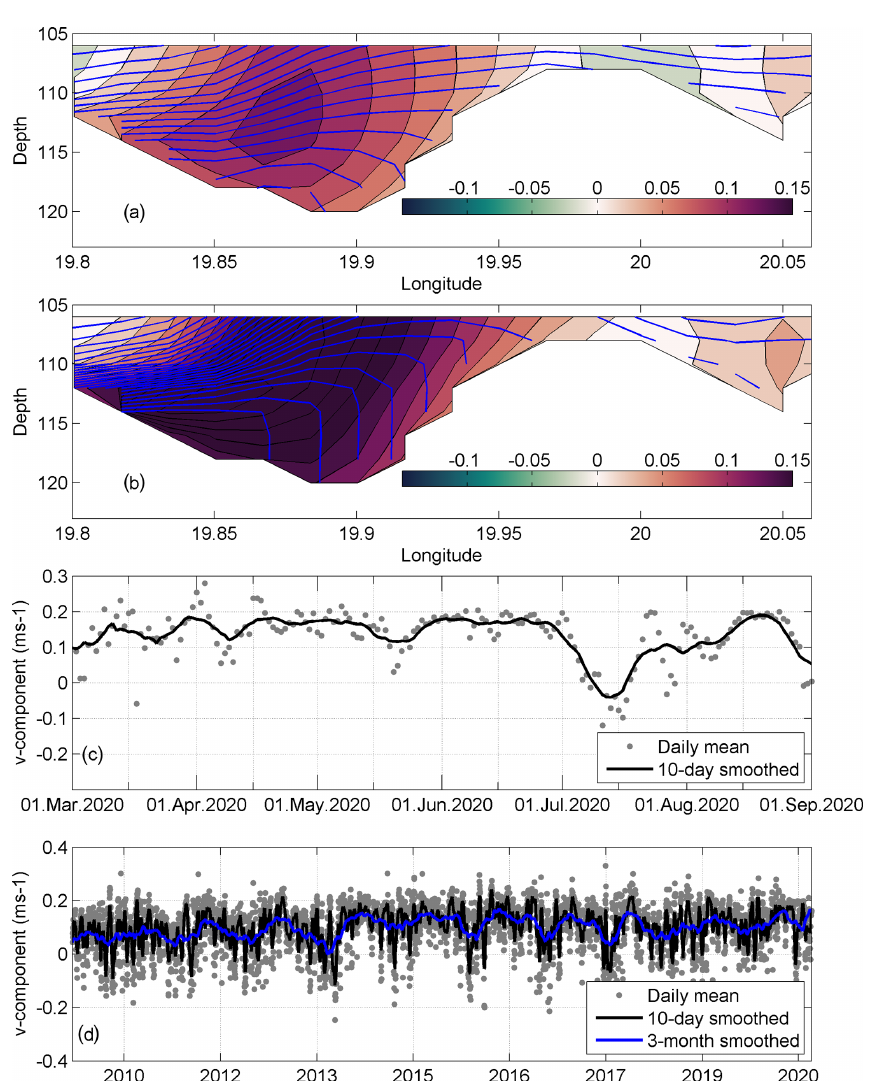
Figure 14. (a) Mean simulated meridional current component v (positive northward) and density isolines at the section below 105m depth (the section location is shown as a red line in Fig. 1b) in 2010–2020. (b) Mean simulated meridional current component v and density isolines at the section below 105m depth from 27 May to 4 June 2020 during a northerly wind impulse. In color scale, contours with a step of 2cms − 1 show the current v component (ms − 1 , positive northward) and blue lines show density isolines with a step of 0.05kgm − 3 . (c) Time series of the v component below 105m at the sill. Dots mark the daily mean and the bold line the 10d smoothed v component from March to September. (d) Time series of the v component below 105m at the sill. Dots mark the daily mean; the bold black line marks the 10d smoothed and the bold blue line the 3-month smoothed v component in the period